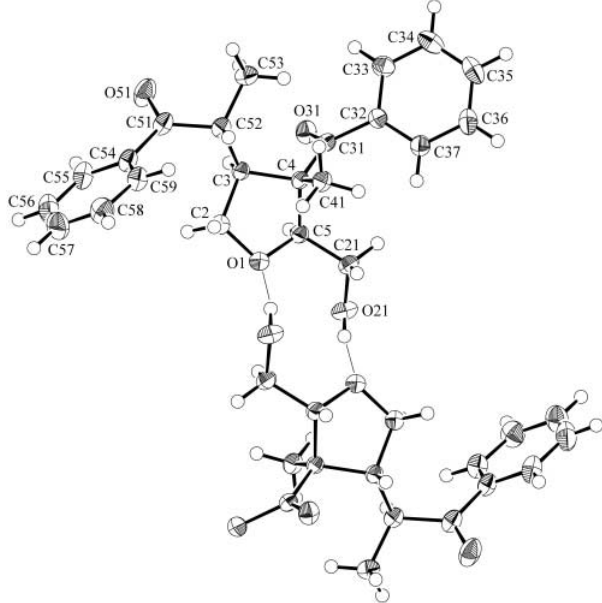
Table 2. Atomic coordinates and displacement parameters (in Å 2 )